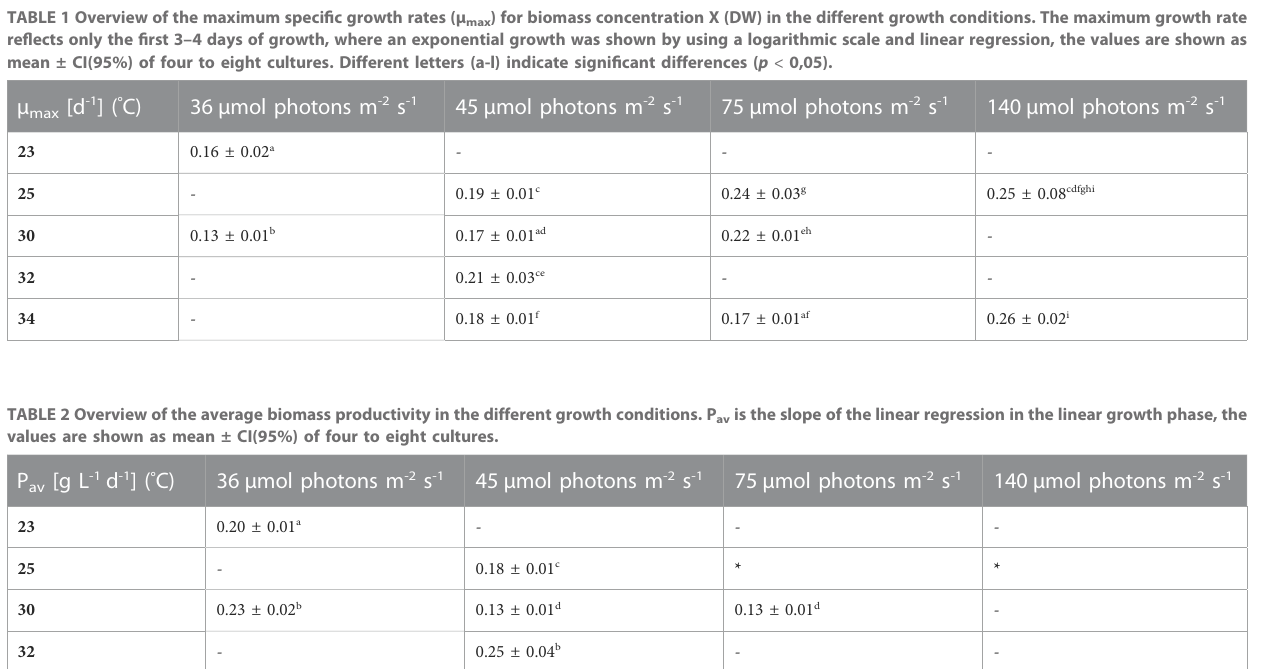
*Linear growth phase too short for analysis. Different letters (a-e) indicate signi fi cant differences ( p <